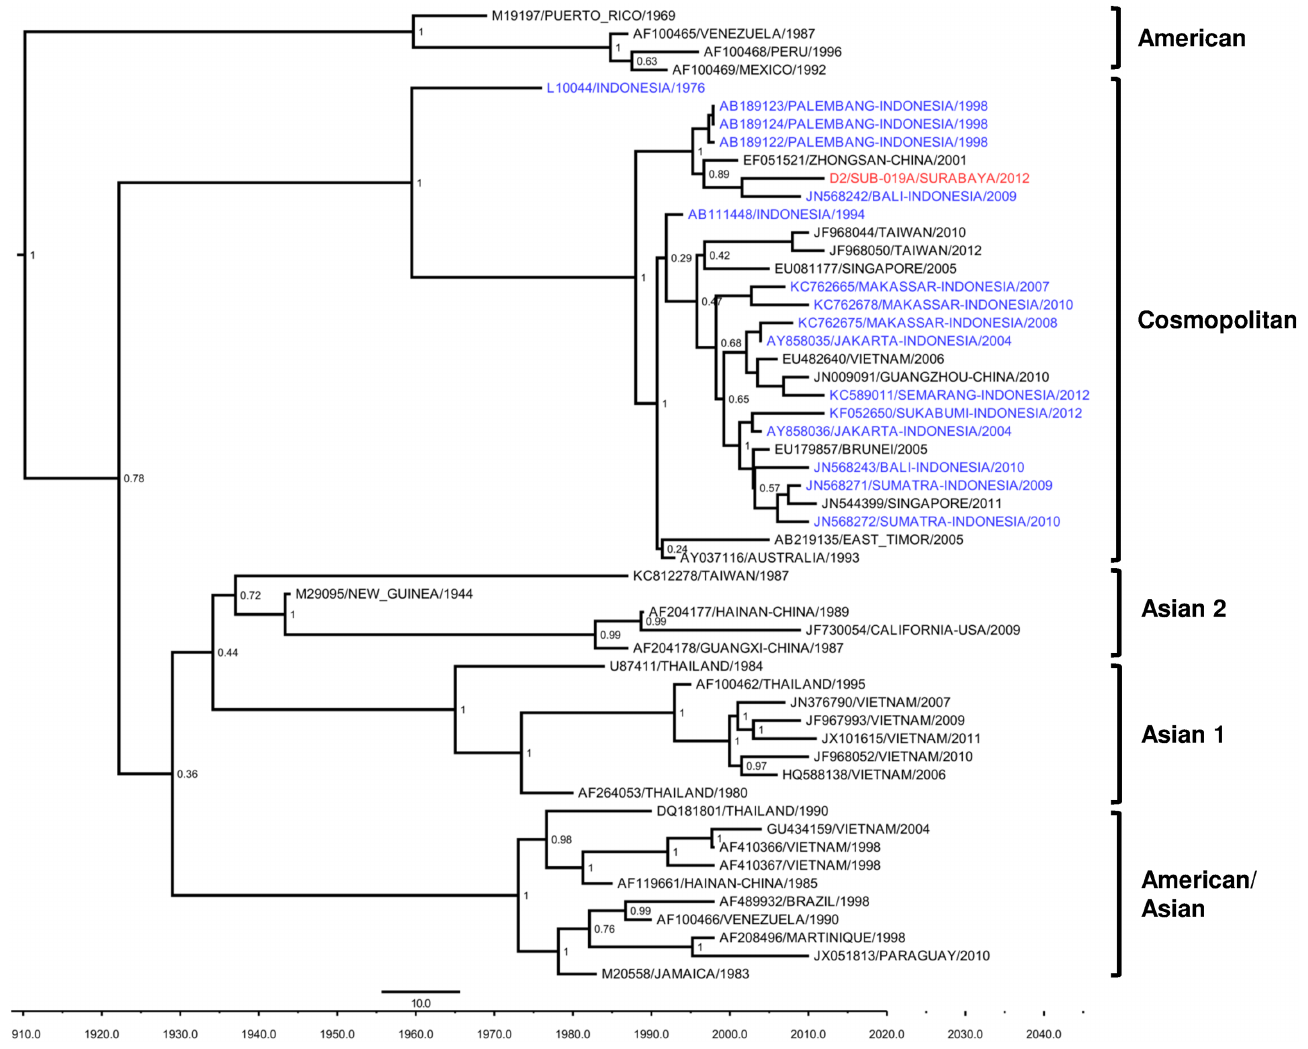
Fig 3. MCC tree of DENV-2 genotype groupings generated by Bayesianinference method as implemented in BEAST using the GTR evolution model and gamma parameter rates from the E gene sequences. The Surabaya 2012 isolate (red font) was groupedinto Cosmopolitan Genotypesbased on classification by Twiddy et al [28], together with isolates from other cities in Indonesia(blue font). The posterior probabilities of the clades are indicatedas numbers in the node labels.